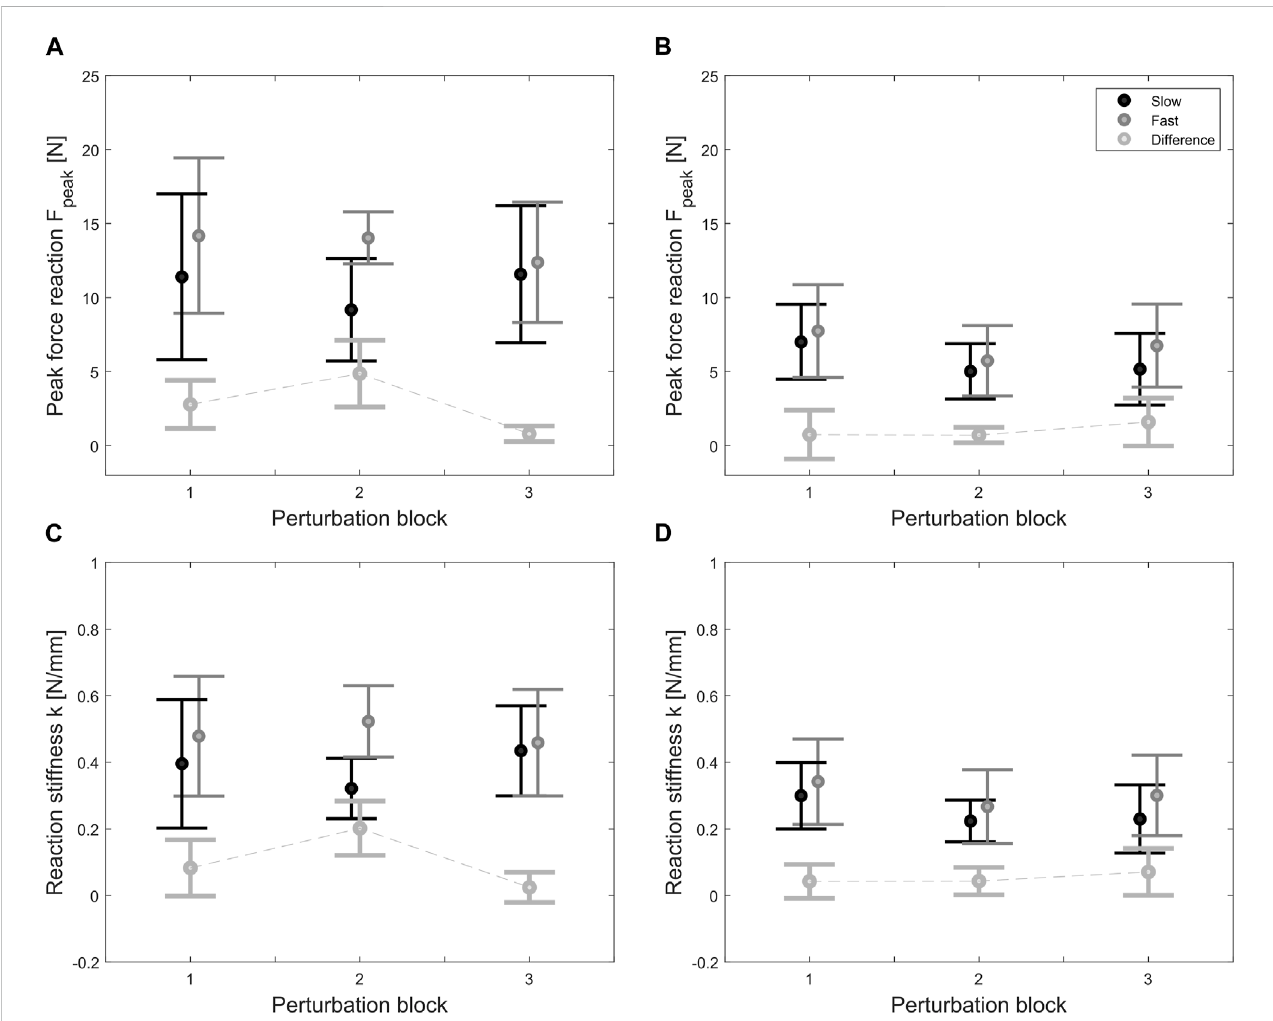
Average peak force and stiffness results at the three different perturbation blocks in the stroke [ (A,C) respectively] and unimpaired group [ (B,D) , respectively].Blackandgraylinesrepresenttheresultsafterslowandfastramp-and-holdperturbations(20 mm,150and250 ms).Thelightgraydottedlineis the difference between fast and slow results, which represents the trend in speed-dependency (i.e., zero corresponds to no speed-dependency) over